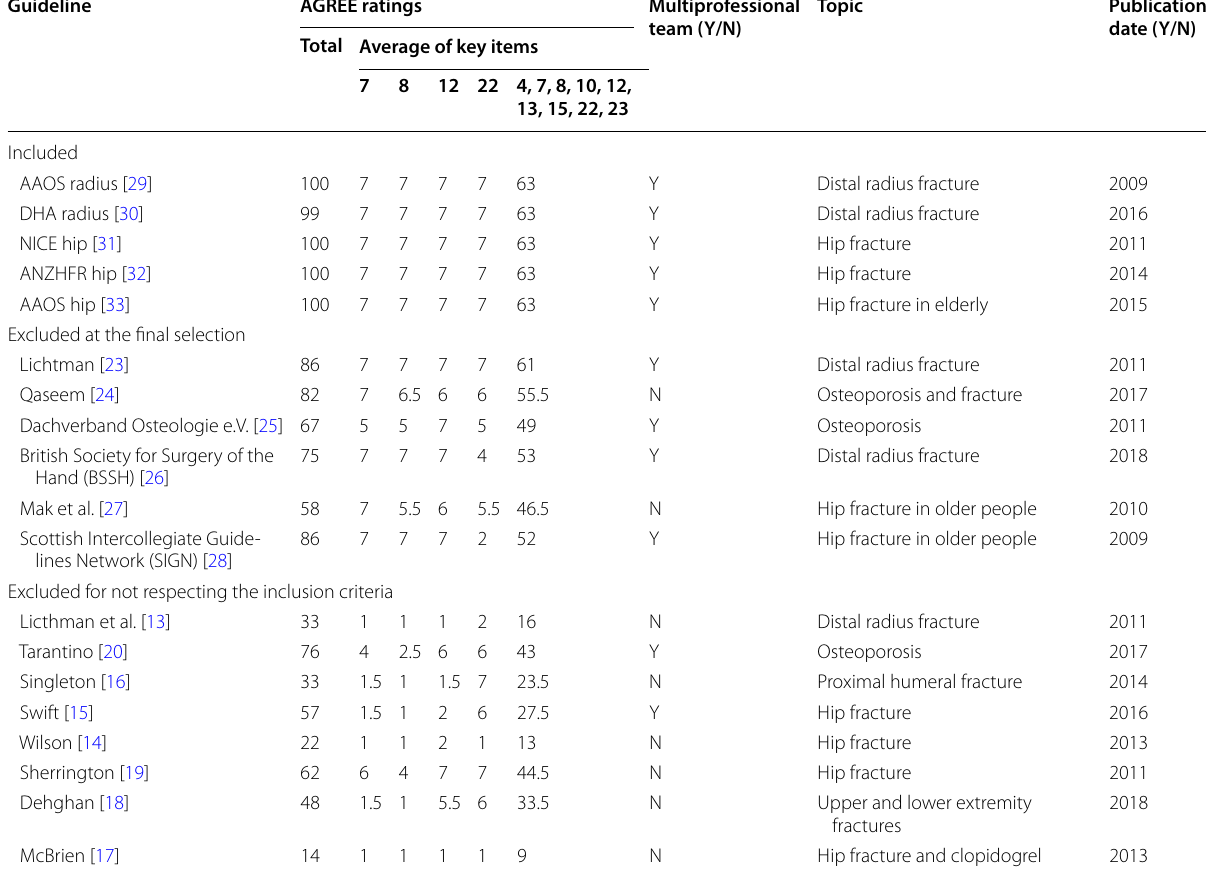
Table 1 Guidelines found and selected, and their assessment against the criteria used to reach the final choice Guideline